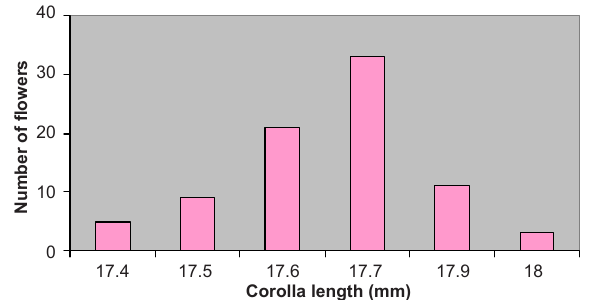
Figure 1. Frequency distribution of corolla length in Sarpagandha